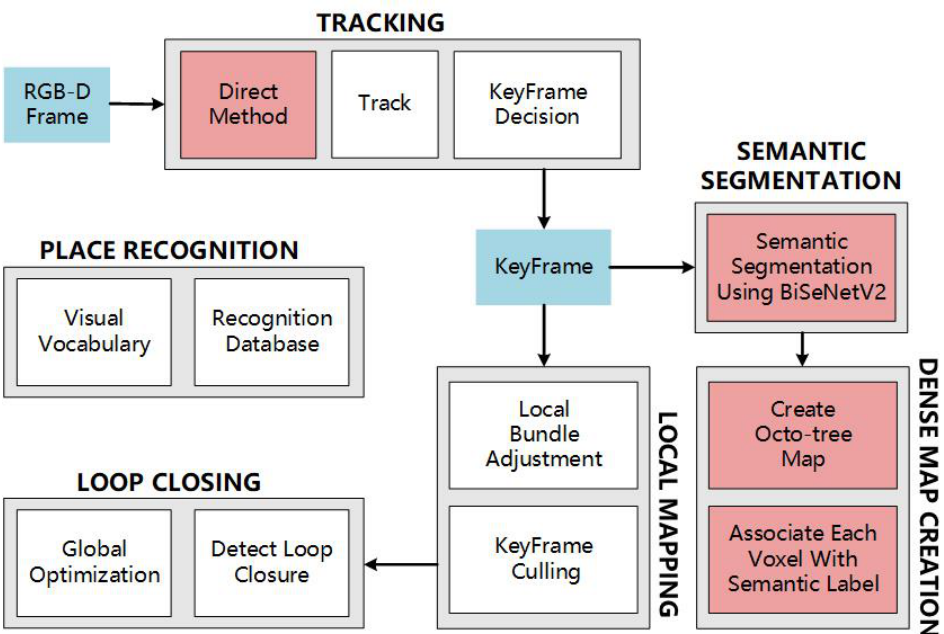
Figure 2. The framework of our system. The blue boxes represent the important data to be processed in the system, the red boxes represent the new parts added to the original framework, and the white boxes include the local mapping thread, loop closing thread, and place recognition parts, which are the same as